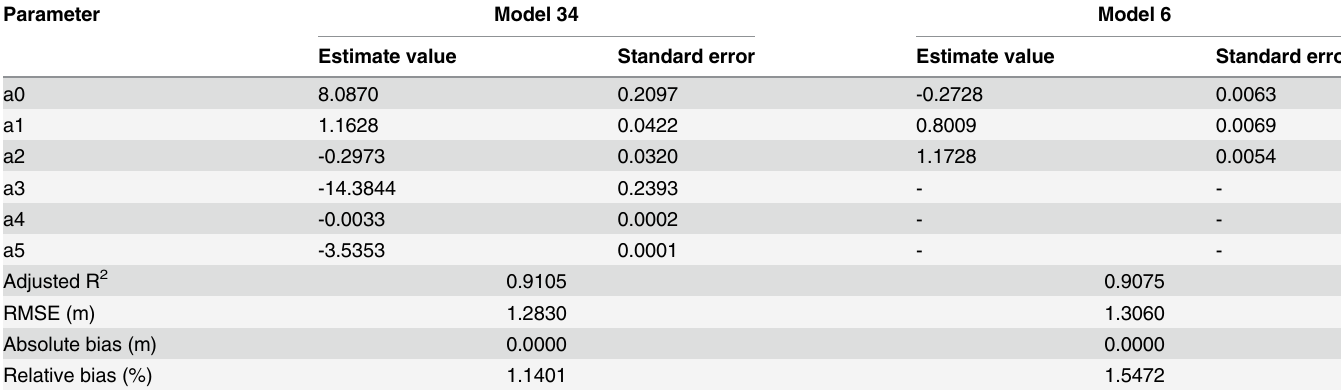
Table 6. Parameter estimates and fitting statistics of the final models using all data.